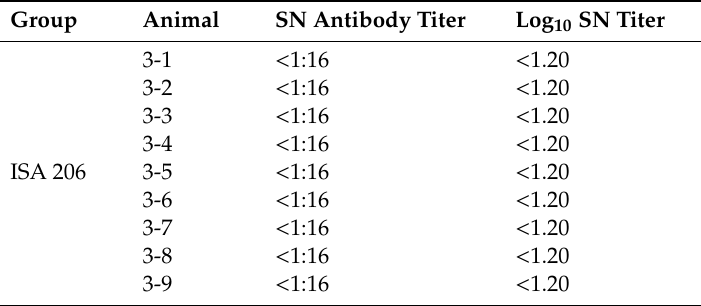
Figure 3. Identification and quantitation of the proteome. ( A ) The distribution of peptide matching error. ( B ) The distribution of peptide length. ( C ) The distribution of protein molecular weight. ( D )